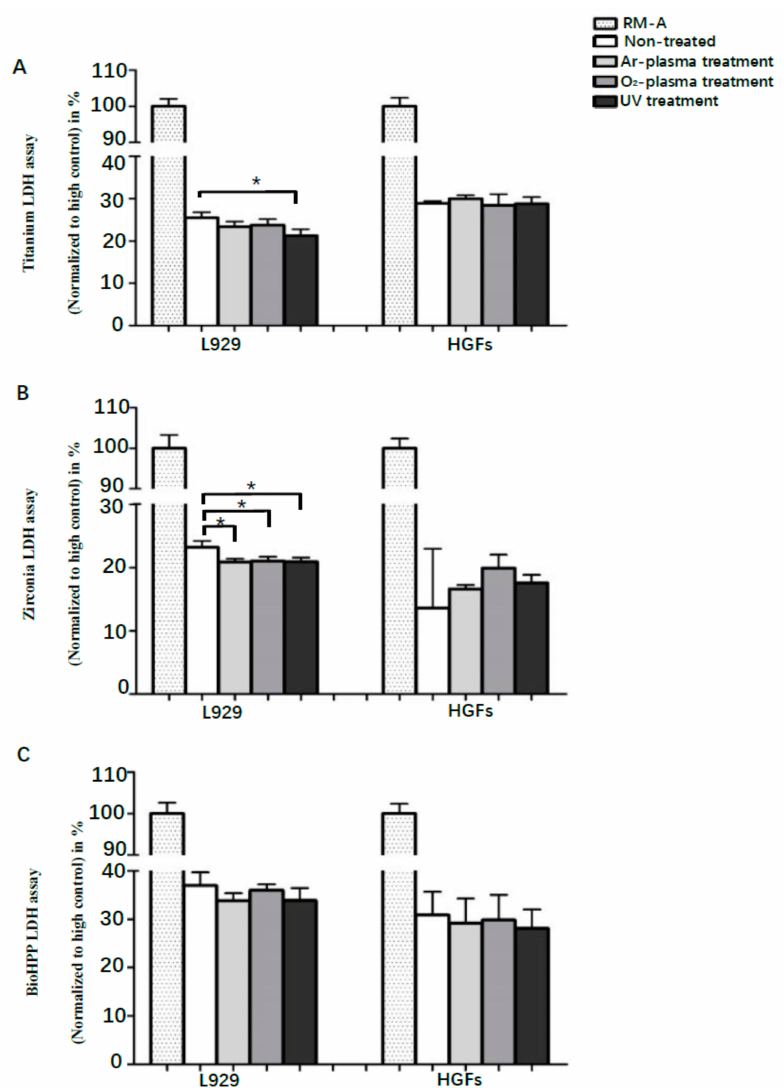
Figure 4. Toxicity of L929 and HGFs on di ff erent surface-treated titanium, zirconia and BioHPP after 48 h. Toxicity of L929 and HGFs on controls and surface-treated titanium ( A ), zirconia ( B ) and BioHPP ( C ) disks after 48 h of incubation. UV light treatment led to significantly decreased toxicity on titanium and zirconia, and NTP on zirconia, using L929 cells. However, there were no significant di ff erences on titanium, zirconia and BioHPP using